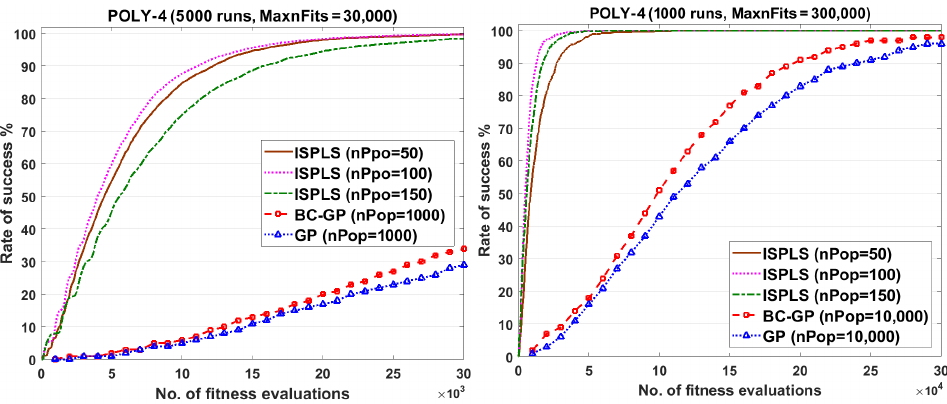
Figure 5. Performance of ISPLS, BC-GP and GP algorithms for the POLY-4